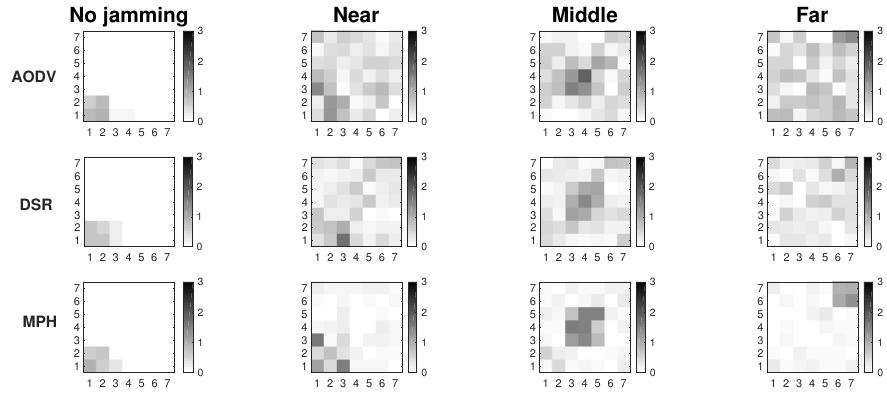
Figure 7. Comparison of energy per node under stable and attacked